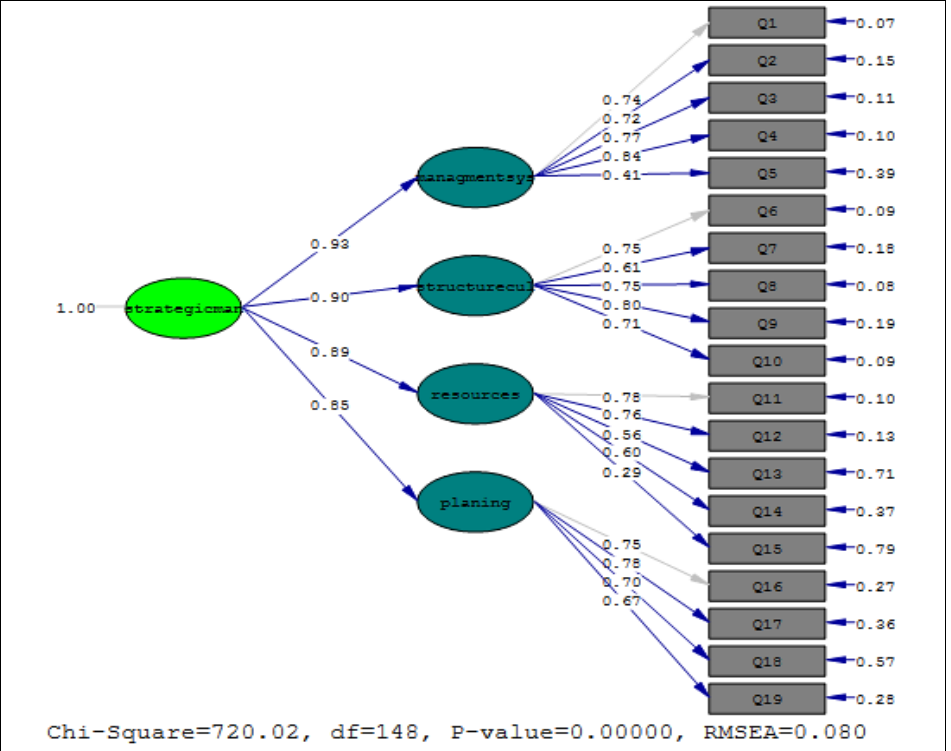
Figure 4 . A model for measuring strategic barriers in standard estimation.